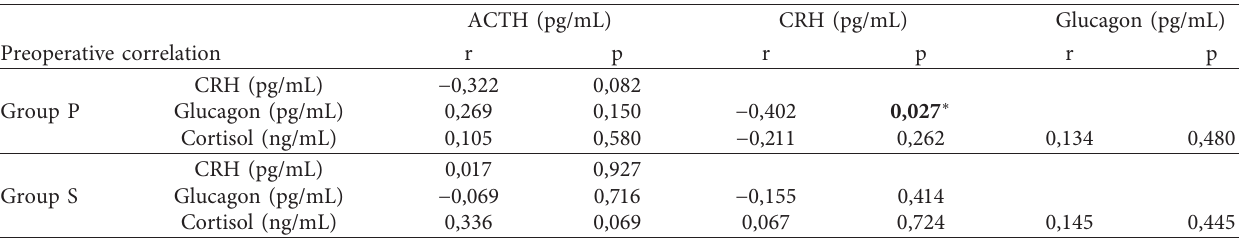
Table 4: Preoperative correlation analysis of blood variables between groups.